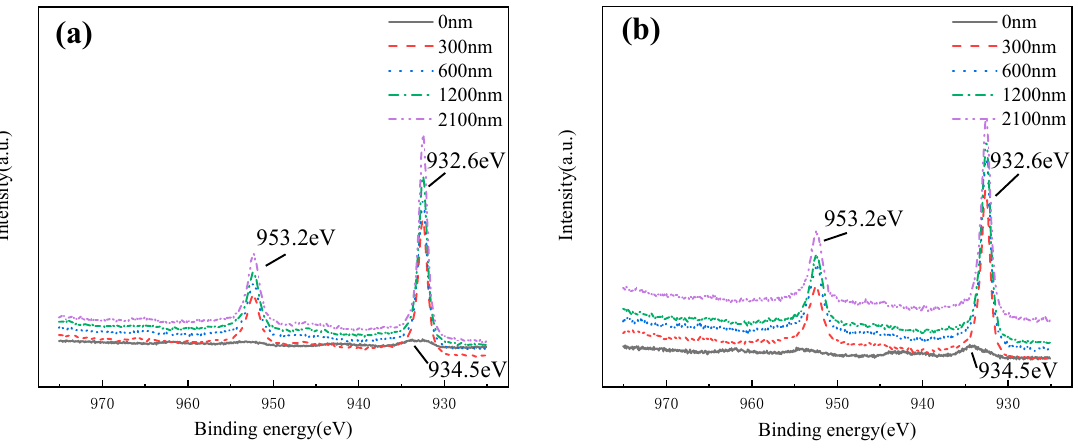
Figure 21. Cu 2P spectral lines of HAZ corroded in flowing seawater: ( a ) 3 m/s, ( b ) 5 m/s .